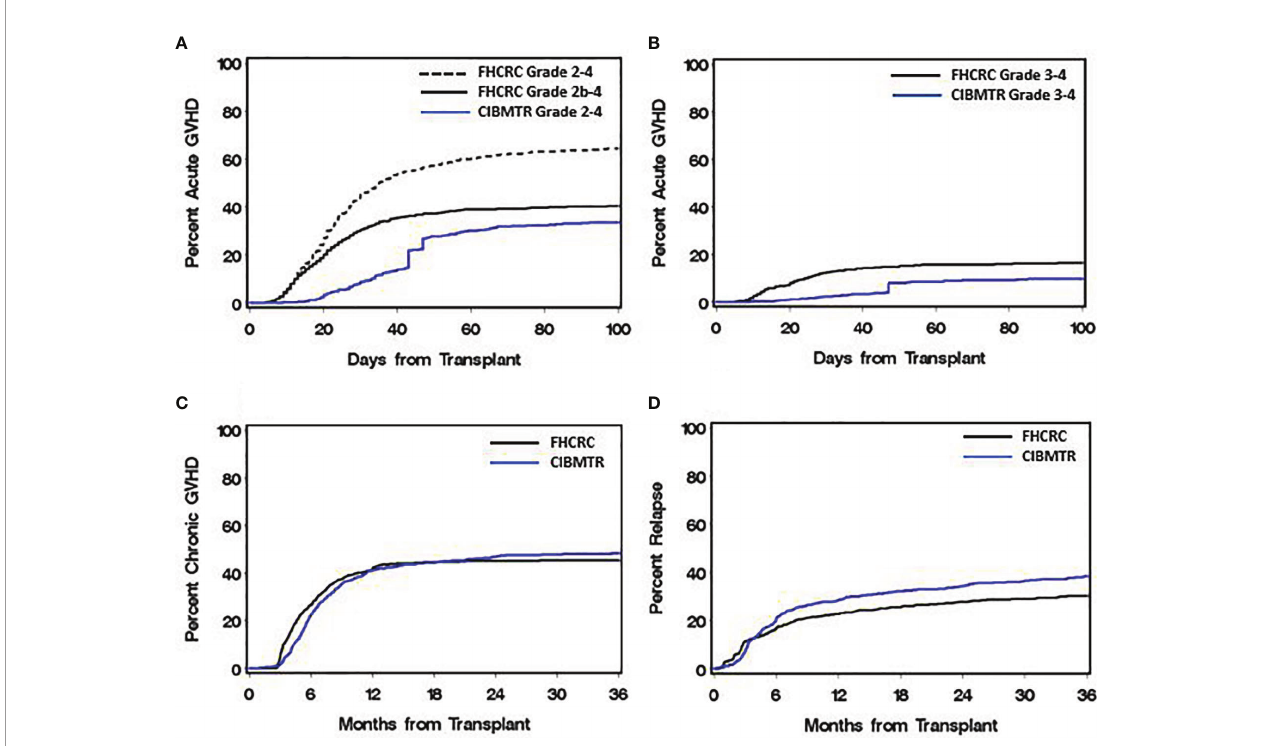
FIGURE 1 | Cumulativeincidence frequencies of acute GVHD, chronicGVHDand relapse between the discovery(FHCRC)and replication (CIBMTR) cohorts. (A) In the FHCRC cohort, grade2-4 acute GVHDincludes isolated stage 1 gastrointestinal GVHD,while grade2b-4 acute GVHD excludes isolatedstage 1 gastrointestinal GVHD. (B) Grade 3-4 acute GVHD. (C) Chronic GVHD was assessed byhistorical criteria inboth cohorts. (D) Relapse includes recurrent orprogressive malignancy after